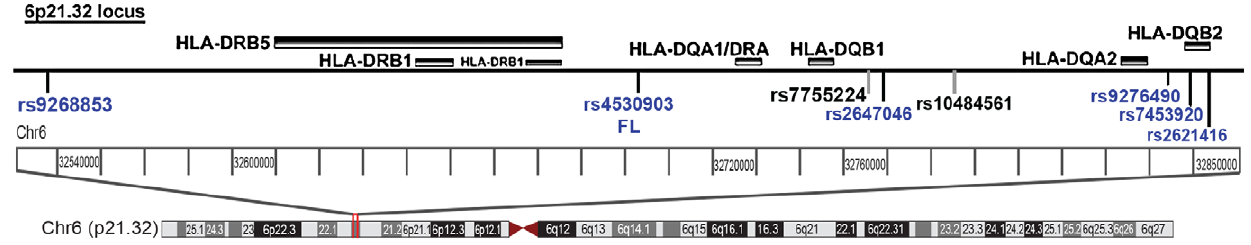
Figure 4. The Chr6p21.32 locus depicting the novel loci near the HLA II locus. SNPs marked in blue are novel SNPs that are significant in LYM, NHL or FL. The two SNPs previously reported are rs7755224 and rs10484561 (in